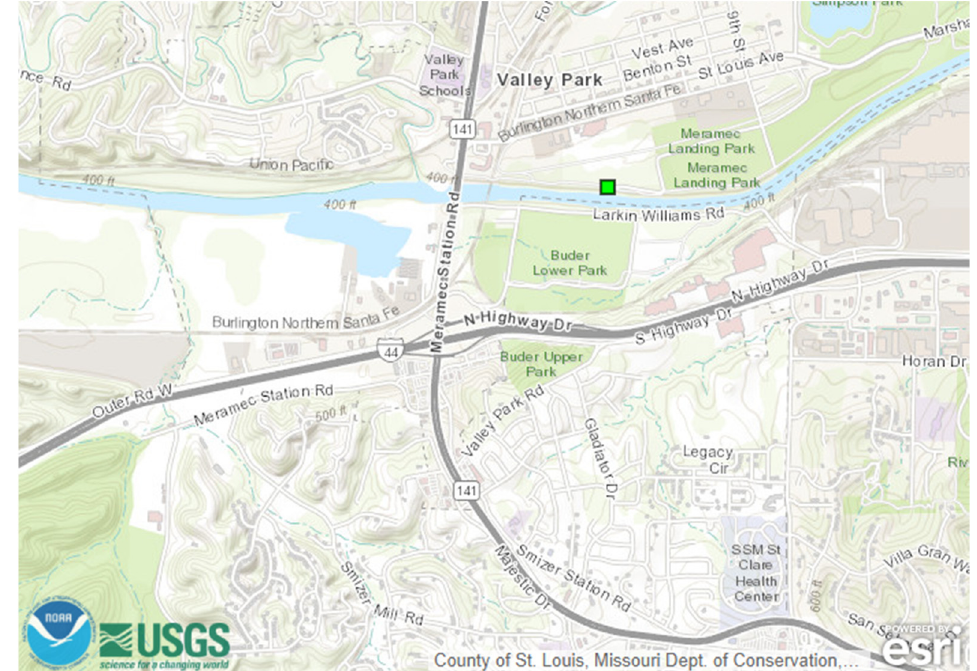
Figure 3. Gauge location in Meramec River [40].